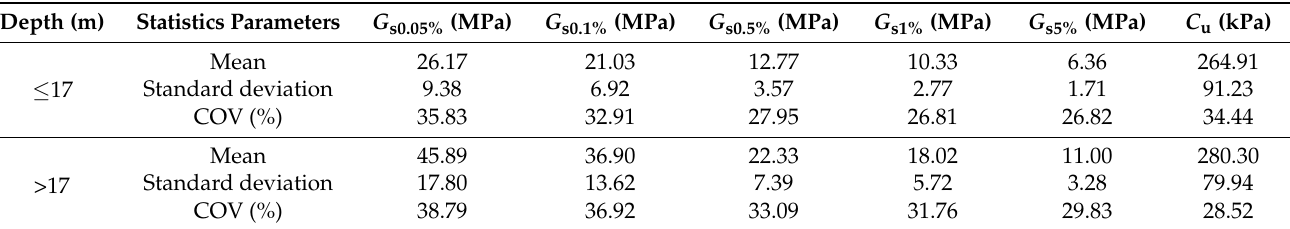
Table 2. Statistics of the secant shear modulus and undrained shear